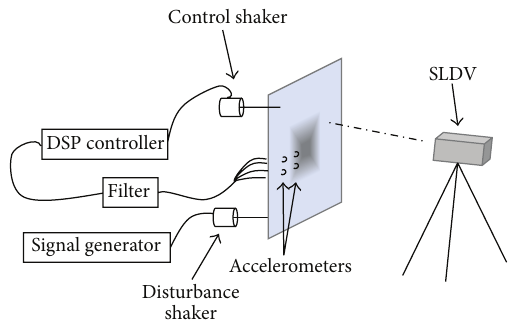
Figure 15: Schematic of the experimental